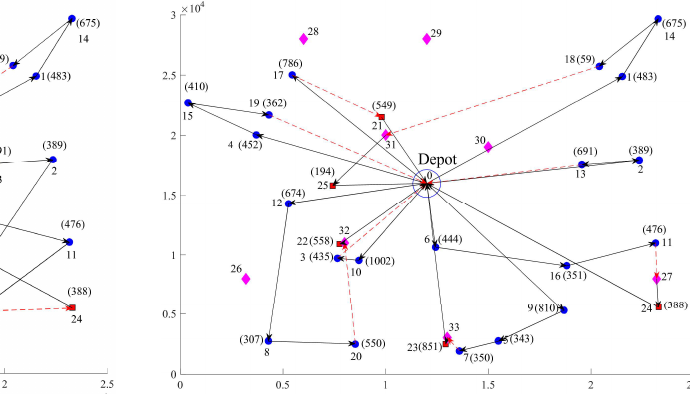
Fig. 2. Electric vehicle routing problem with backhaul